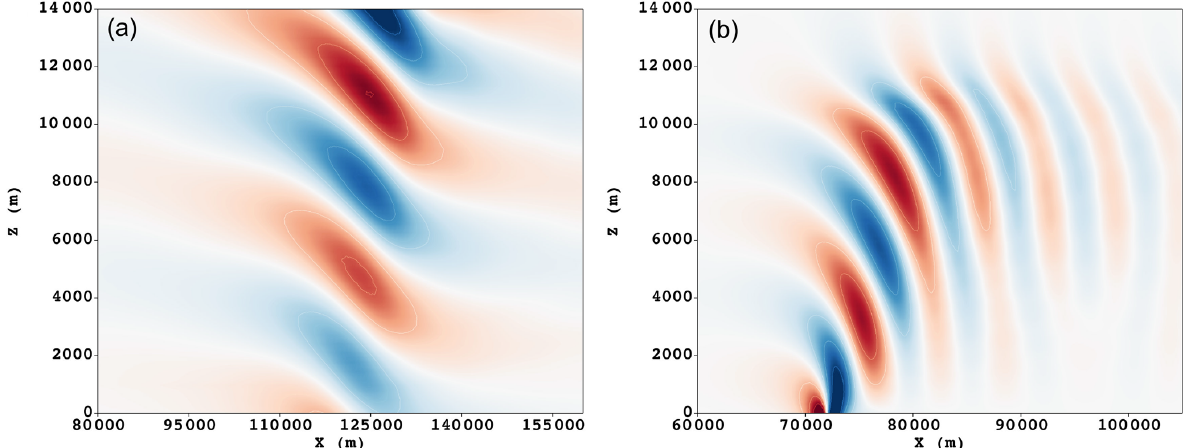
Figure 6. Vertical velocity w for two linear mountain wave tests. Velocity contours are shown in the range from − 4 × 10 − 3 ms − 1 (blue) to 4 × 10 − 3 ms − 1 (red). (a) Hydrostatic test at t = 15000s, with an effective horizontal resolution (cid:49)x = 500m and effective vertical resolution (cid:49)z = 240m with N = 4. (b) Nonhydrostatic test at t = 18000s, with an effective horizontal resolution (cid:49)x = 200m and effective vertical resolution (cid:49)z = 160m with N =